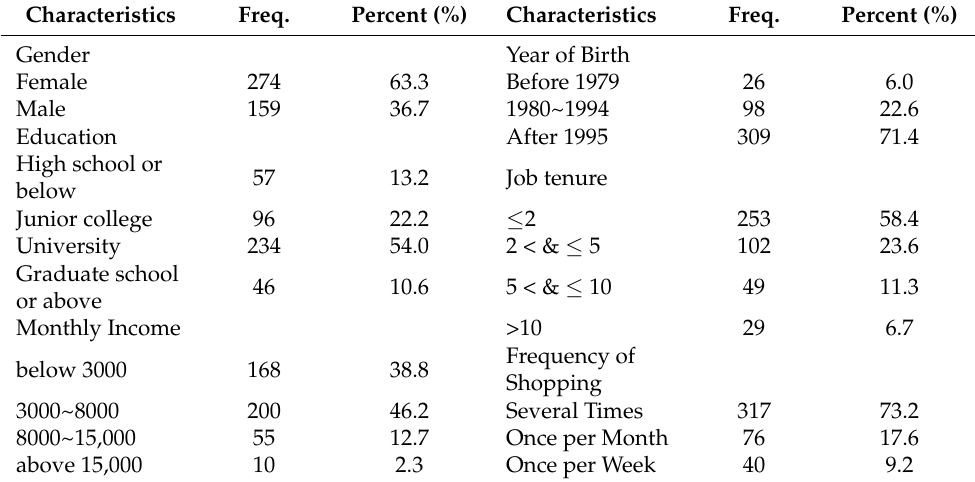
Table 1. Demographic statistics ( n =